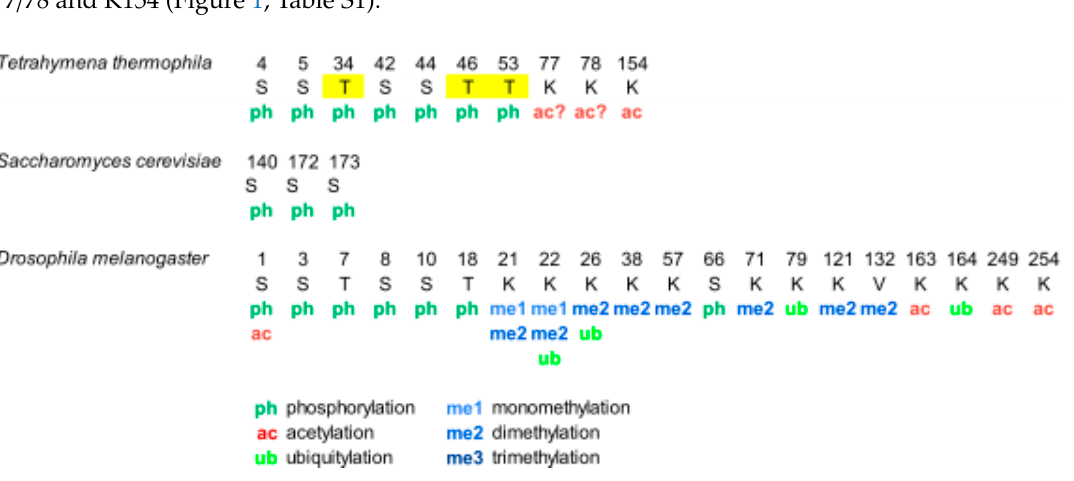
Figure 1. Modified positions in histone H1 of Tetrahymena thermophila , Saccharomyces cerevisiae , and Drosophila melanogaster . The positions refer to the mature protein, which lacks the initial methionine. Highlighted in yellow, phosphorylation in cyclin-dependent-kinase (CDK) consensus motifs. Question marks are included in post-translational modifications (PTMs) of ambiguous assignment.